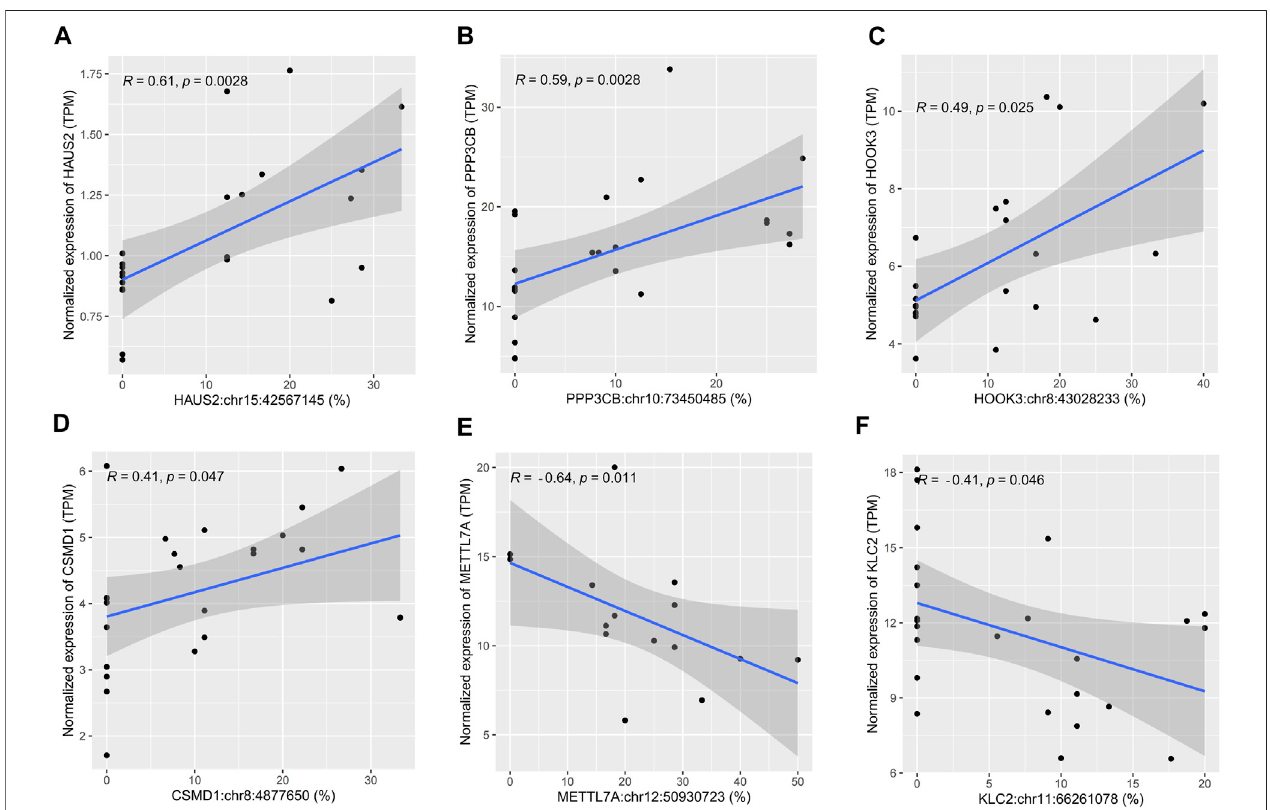
FIGURE 3 | Scatter plots showing cis-regulatory effects of A-to-I RNA editing on gene expression. (A – F) The correlation between the editing level and gene expression level in human brain samples.